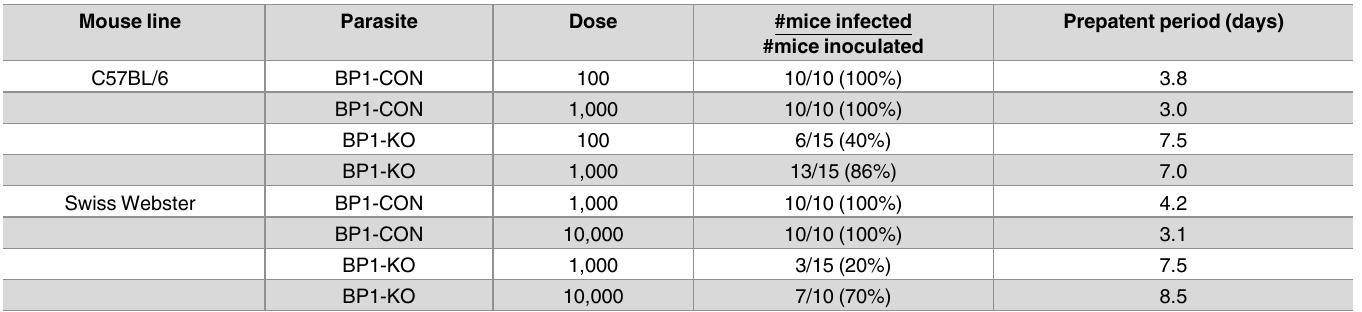
Table 1. In vivo infectivity of berghepain-1 knockout sporozoites as determined by prepatent period. C57BL/6or Swiss Webster mice were inocu- lated i.v. with the indicatednumberof sporozoites. Blood smears were examineddaily starting on day 3 after sporozoiteinoculationand mice were considered negativeif parasites were not detected by day 20. For C57BL/6mice, data from three independentexperiments are pooled;two with BP1-KO clone 1 and one with BP1-KO clone 2. For Swiss Webster mice, data from two independentexperimentsusing BP1-KO clone 1 are pooled. Mouse